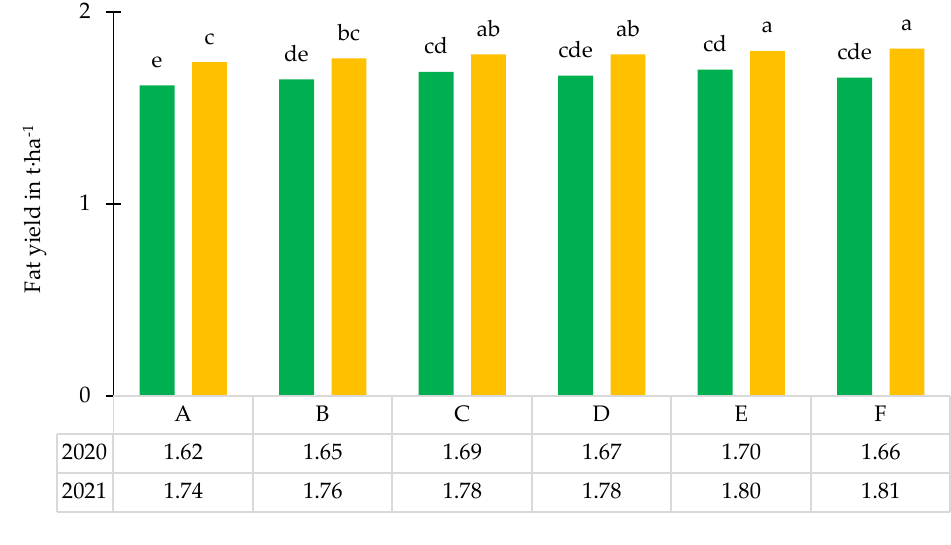
Figure 7. Fat yield in t · ha − 1 . A–F—variants of fertilization. Different lowercase letters indicate significant differences ( p < 0.05) according to the analysis of variance (ANOVA).